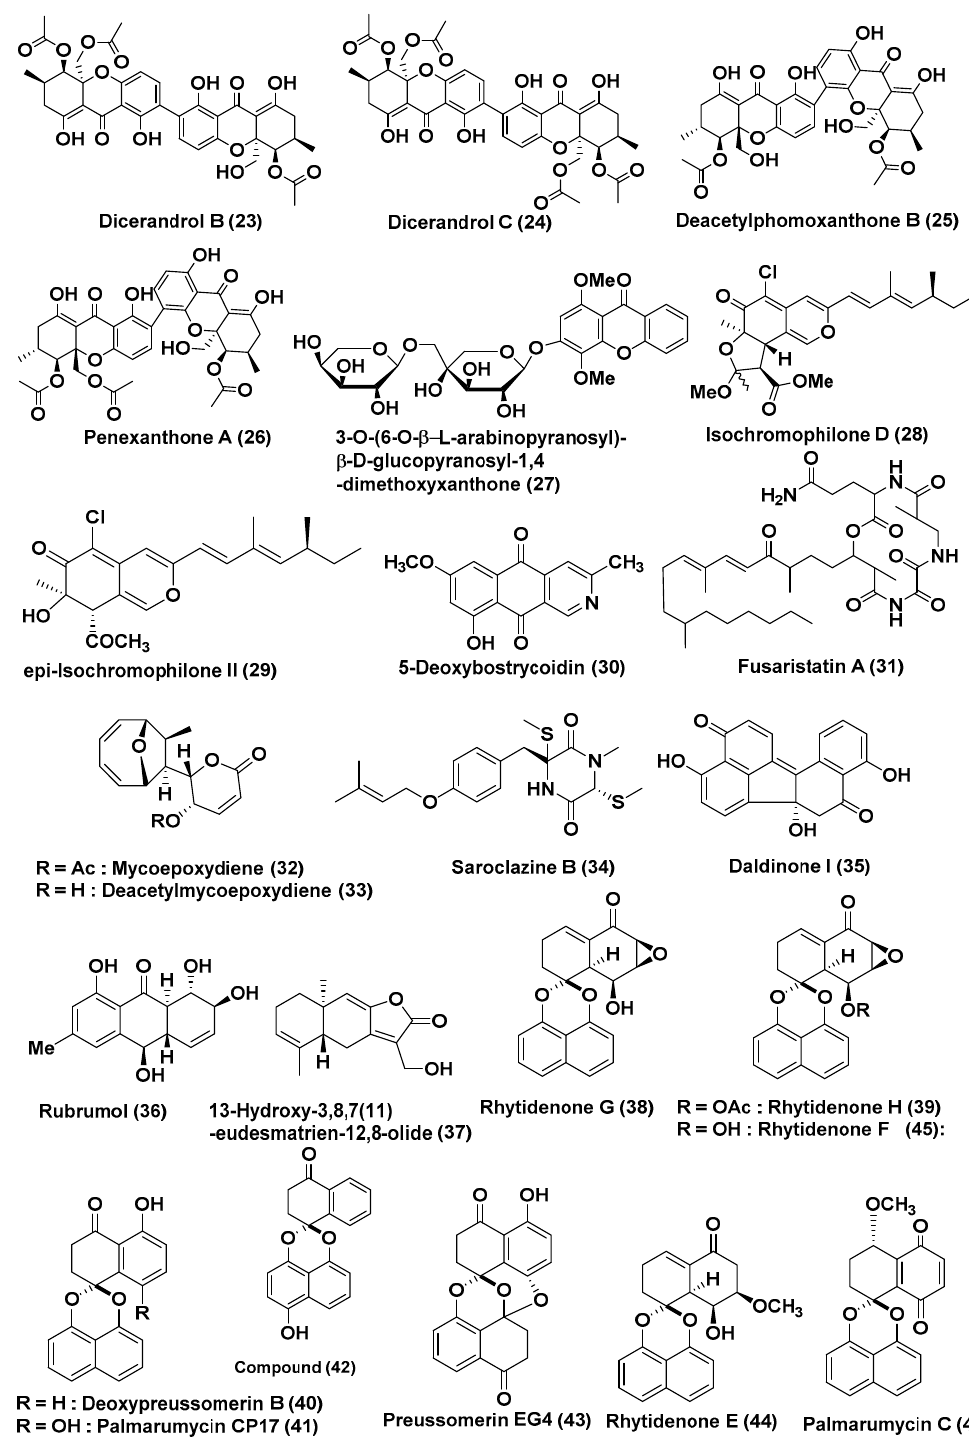
Figure 3. Structures of metabolites isolated from Coelomycetes ( 23 – 33 ) and Ascomycetes ( 34 – 46 ).